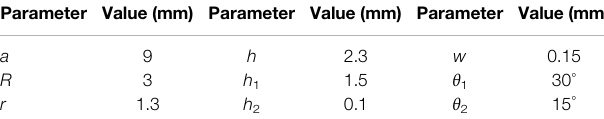
TABLE 1 | Dimensions and parameters of the proposed 3D MA.